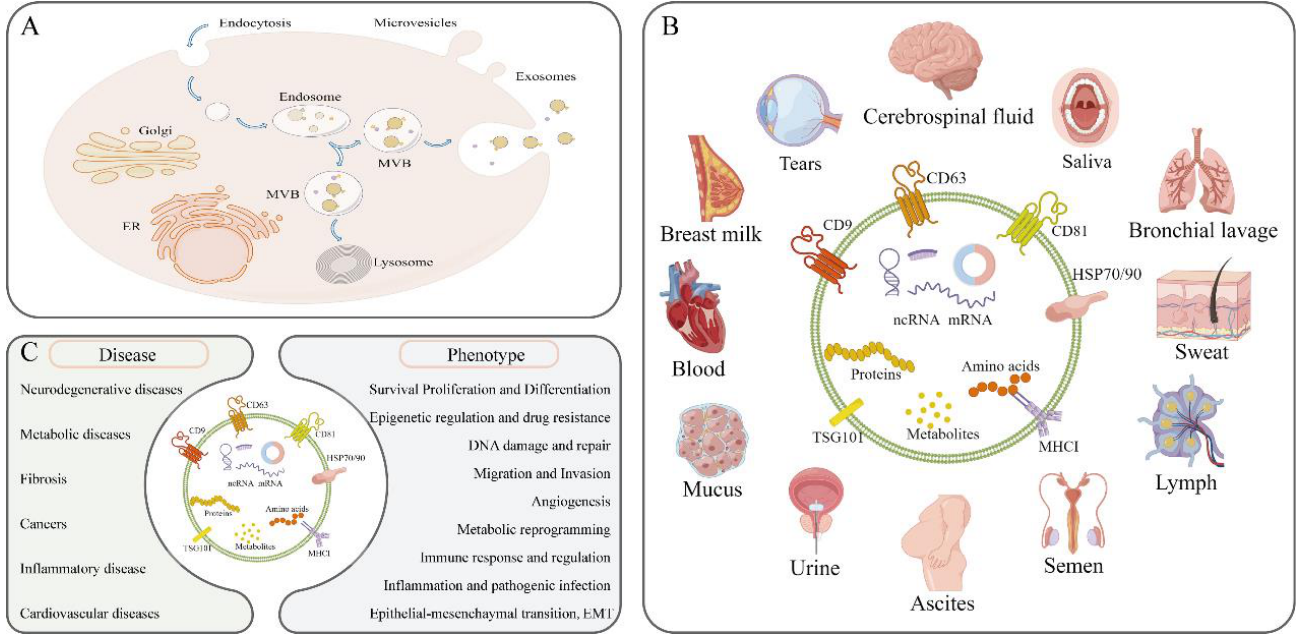
Figure 2. Biogenesis and biological functions of exosomes; (A) Exosomes passing through the in- vagination of the plasma membrane are released through the intracellular multivesicular pathway; (B) Exosomes are found in various bodily fluids and contain cell-derived membrane proteins, cyto- plasmic proteins, nuclear proteins, mRNAs, noncoding RNAs (ncRNAs), and various metabolites; (C) Exosomes play a role in various diseases and phenotypes.